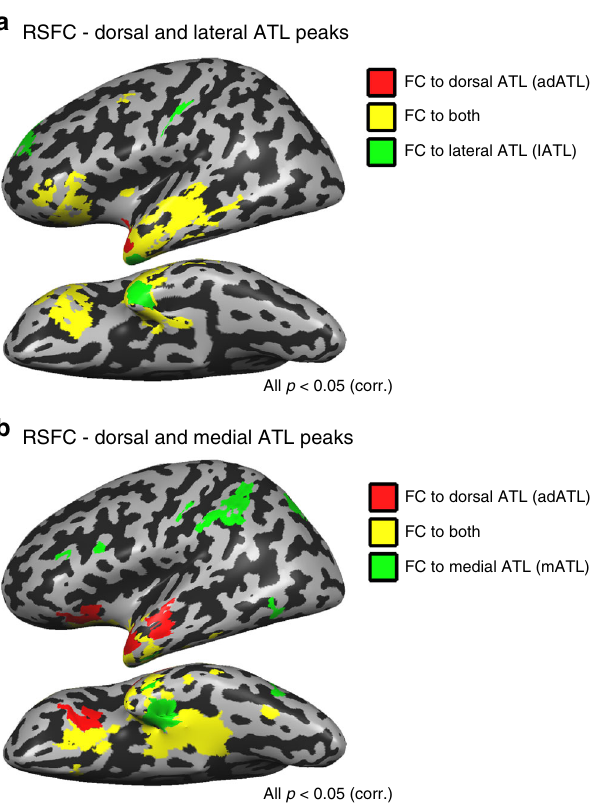
Fig. 6 Different functional networks for different aspects of ATL. a Partial RSFC was computed from the dorsal (red; adATL) and lateral (green; lATL) ATL peaks in the sighted. Overlapping RSFC to both seeds (in yellow) is predominant, showing that these two regions belong largely the same functional network. Similar fi ndings were evident in the blind group, and group differences in the connectivity to these seeds were minimal (see Supplementary Fig. 7A,C,D). b The dorsal and medial ATL regions, which show opposite preferences for perceptibility in the blind (adATL and mATL) belong to largely different functional networks in the sighted. Partial RSFC is plotted for the dorsal (red) and medial (green) ATL. Overlapping RSFC to both seeds is depicted in yellow. Similar fi ndings were evident in the blind group, and group differences in the connectivity to these seeds were minimal (Supplementary Fig. 7B,C,E)